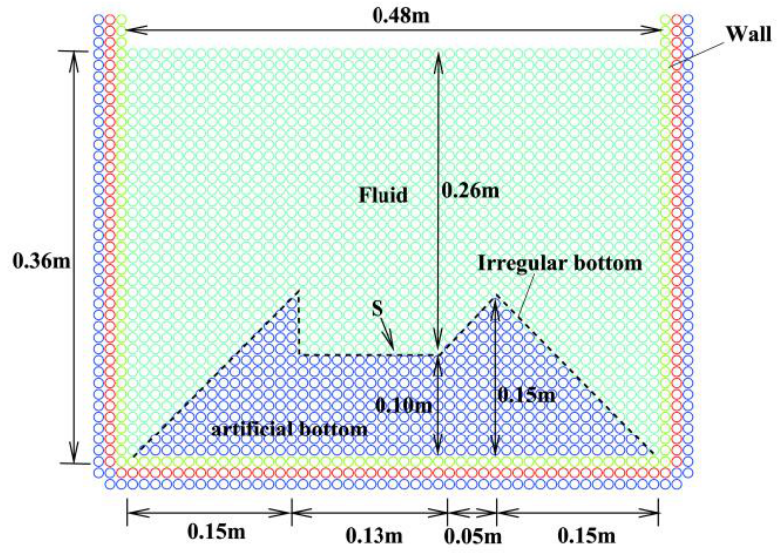
Figure 9. Simulation domain of the hydrostatic calculation in a tank with an irregular bottom.